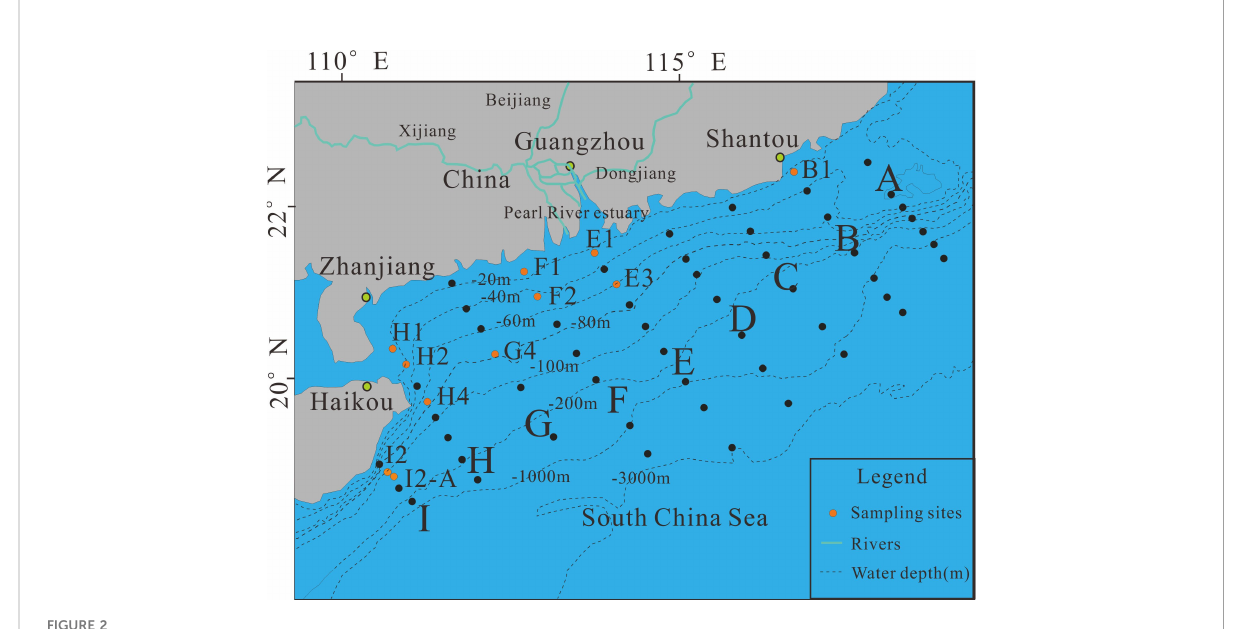
FIGURE 2 Study area and sampling